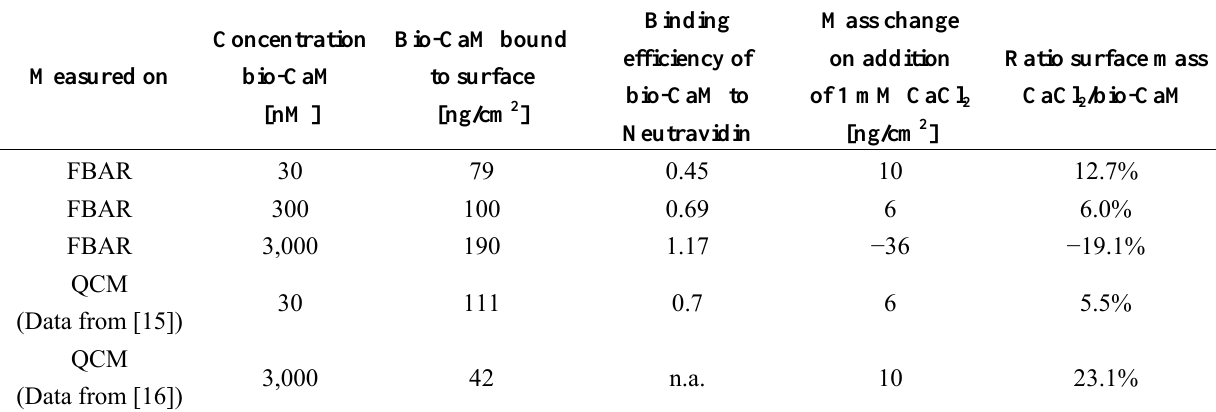
Table 1. Summary of results for the bio-CaM binding and CaCl measurements together with values from QCM literature